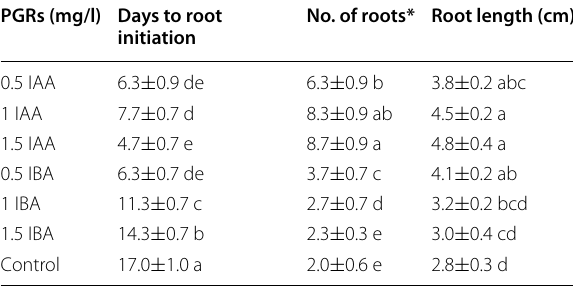
*Data recorded after 4 weeks of culture Data (mean standard error) represent three replicated treatments with 20 ± shoots per replication (control MS medium without PGR). Data for each = column followed by the different letters are significantly different according to Tukey’s test at P =